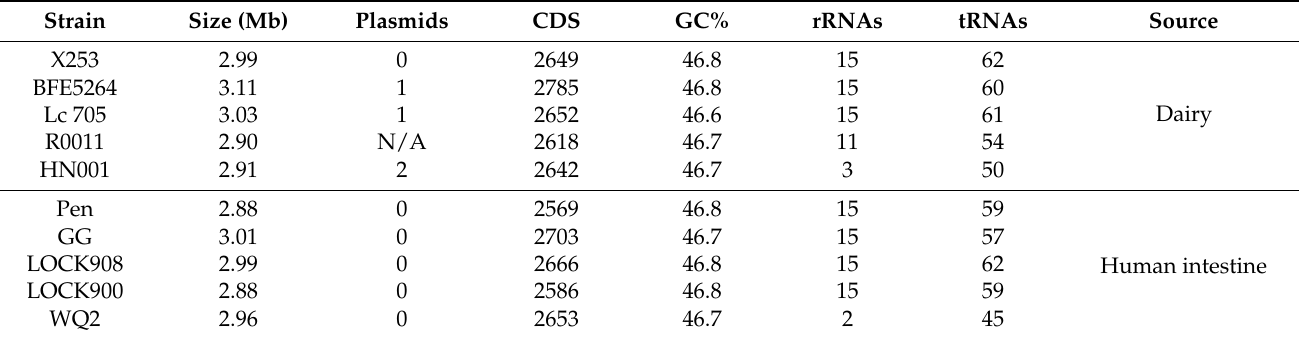
Table 2. Genome features of 10 representative L. rhamnosus genomes.